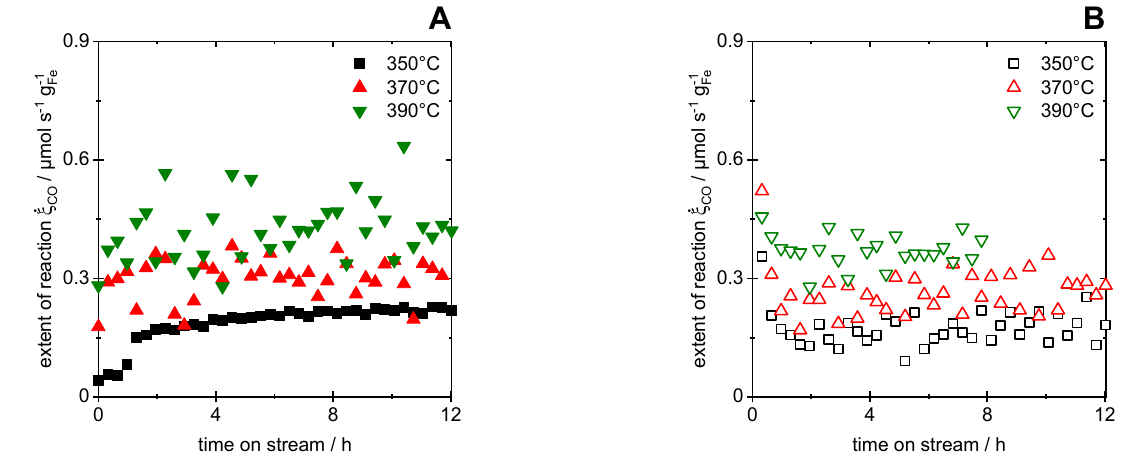
Figure 5. Extent of CO hydrogenation reaction ξ CO as function of time-on-stream at 350, 370 and 390 °C before (( A ), filled symbols) and after (( B ), empty symbols) CO 2 treatment, respectively. A comparison of the results of Figures 3 and 5 allows us to relate the CO conversion with the CH 4 formation before and after CO 2 treatment. Note that the correlation between . n i is ξ the extent of reaction and the change in the molar flow rates of the components ∆ j described in Equation (16). Comparing Figures 3 and 5A (before CO 2 treatment), a